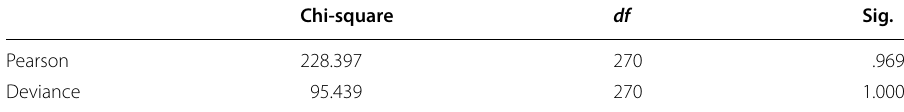
Source Own survey (2022)